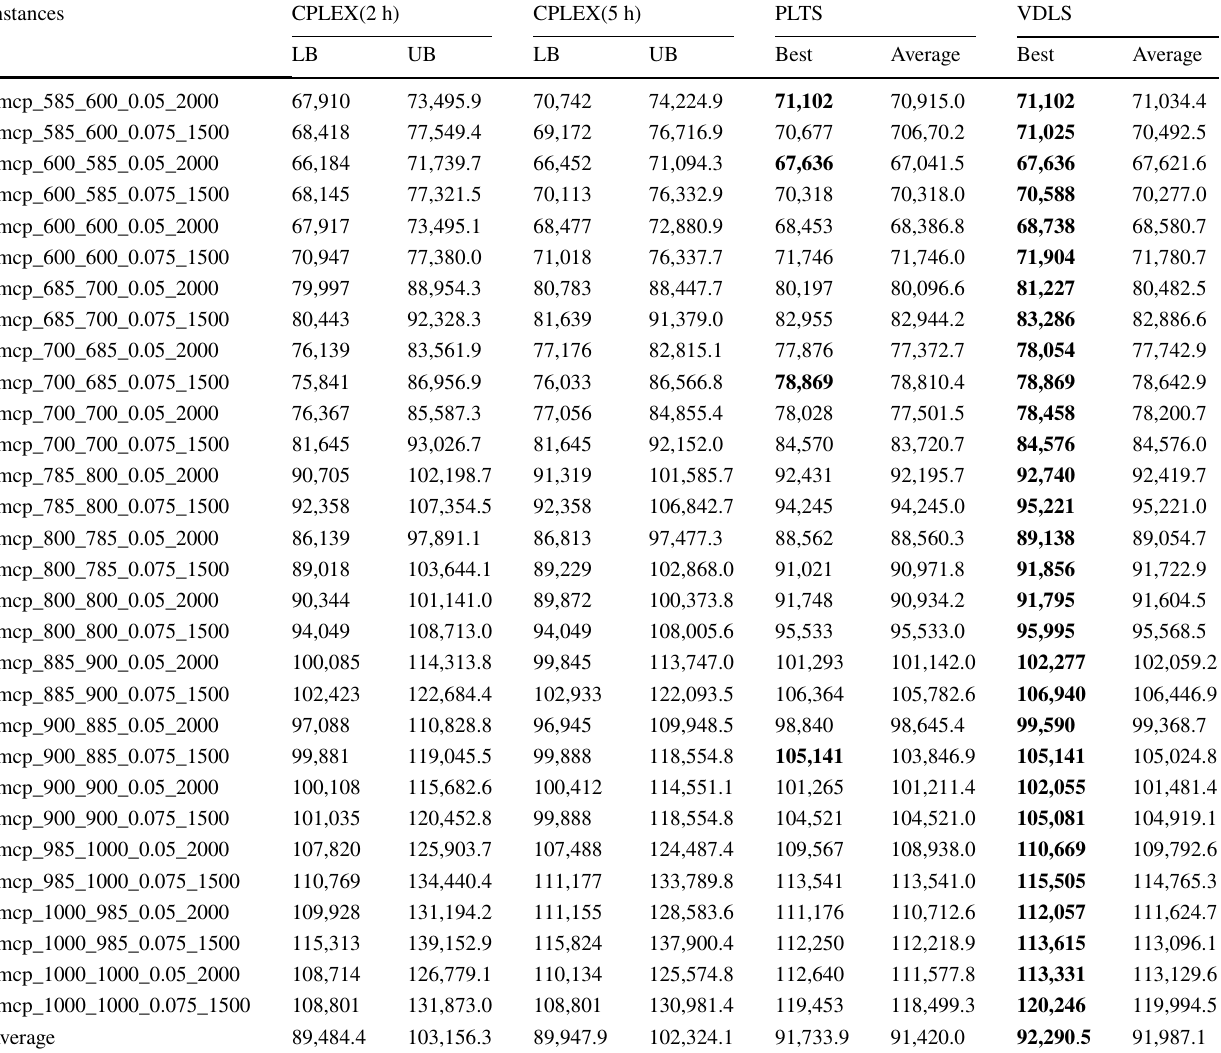
Table 3 Comparison of the PLTS and VDLS with both 30 min of time limit, and the CPLEX solver with 2 h and 5 h of time limit in solving the 30 instances of the first